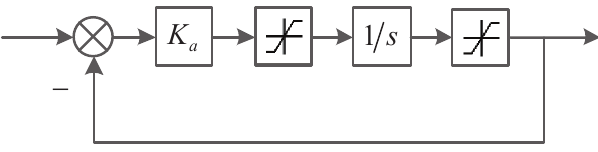
Figure A2. The block diagram for